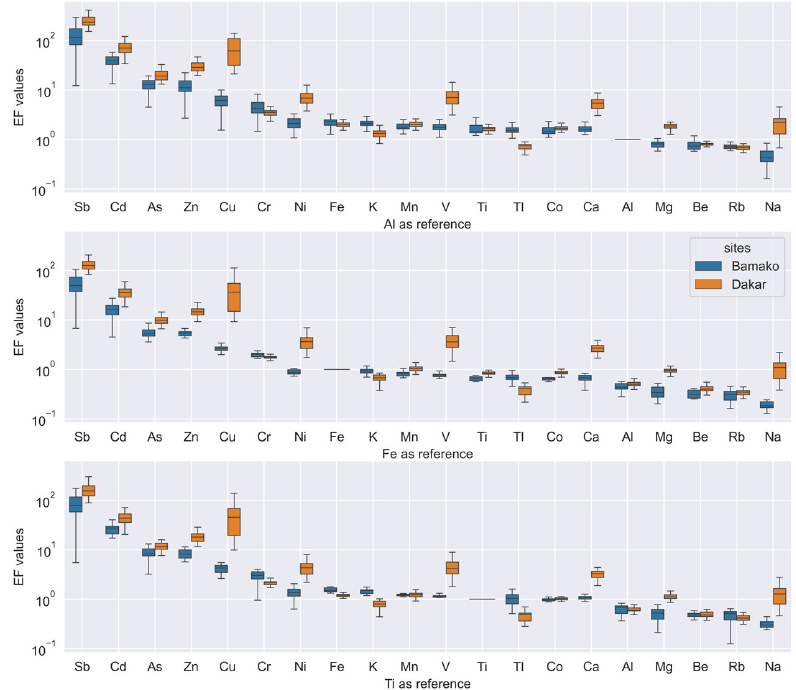
Figure 5. Enrichment factor (EF) values for PM elemental composition calculated in Bamako and Dakar using Al, Fe and Ti as reference elements.